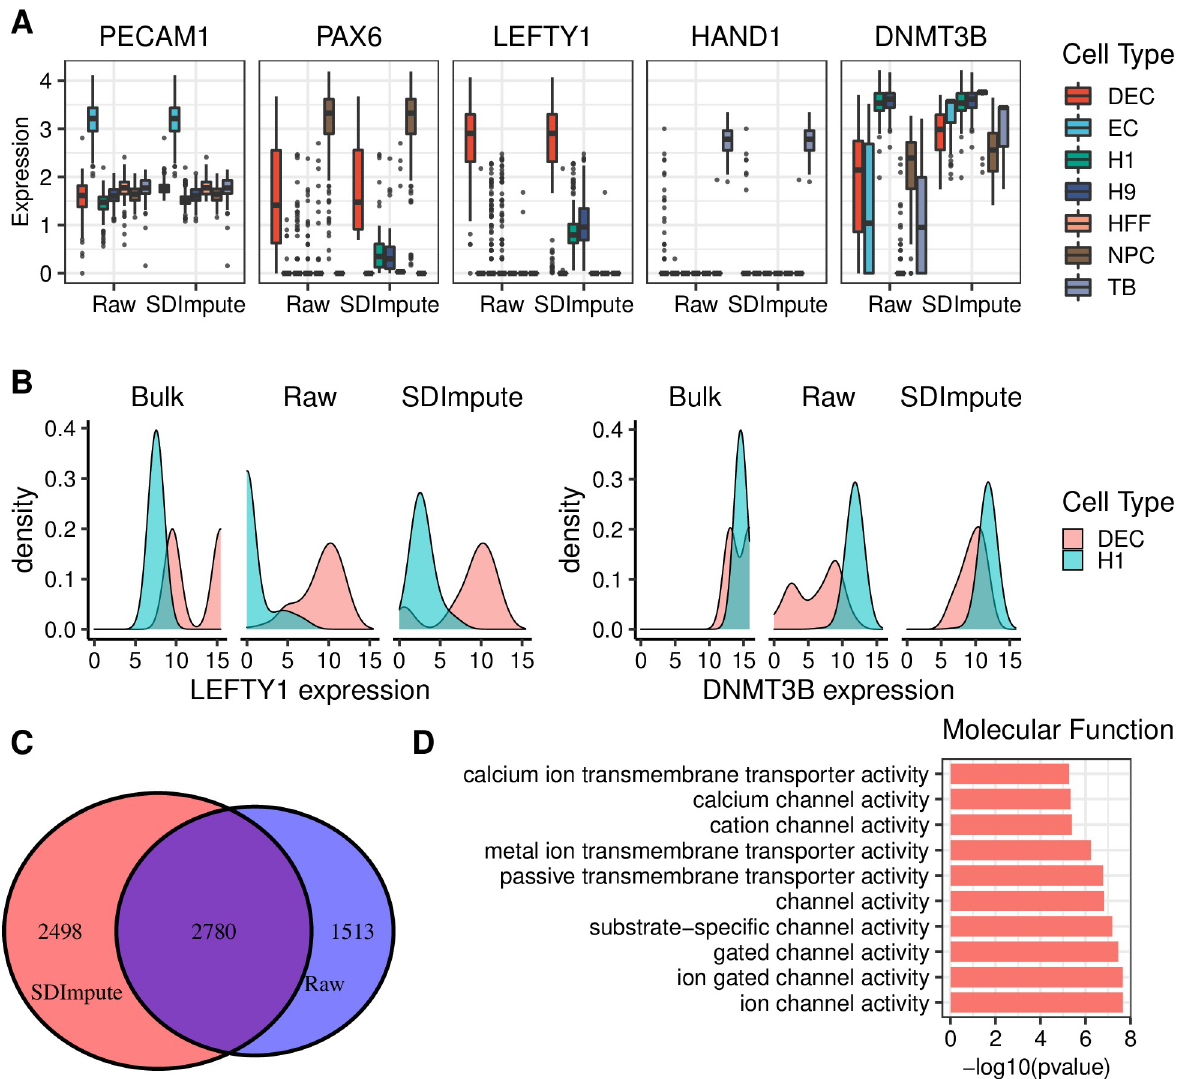
Fig 6. SDImpute improves differential expression analysis in the Cell Type dataset. (A) Box plots show expression levels of marker genes in raw data and SDImpute imputed data. (B) Density plots present the differential expression of two exemplary genes (LEFTY1 and DNMT3B) between H1 cells and DECs in the bulk data, raw data, and SDImpute imputed data, respectively. (C) Venn diagram of the differentially expressed genes (p- value < 0.01) detected in raw data and SDImpute imputed data by DESeq2. (D) Enriched GO terms (p-value < 10 − 3 ) related to the molecular function of the up-regulated genes of H1cells were only detected in SDImpute imputed data.